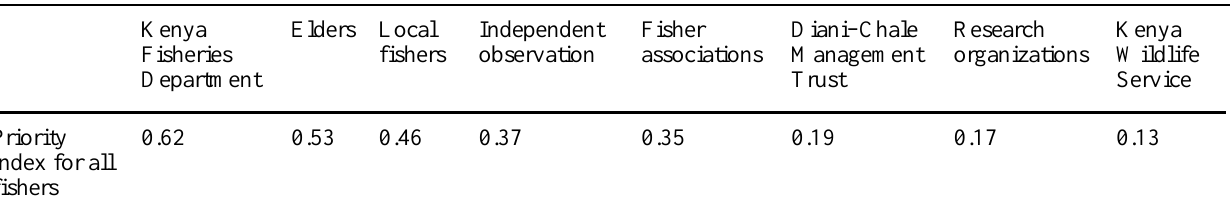
Priority index for all